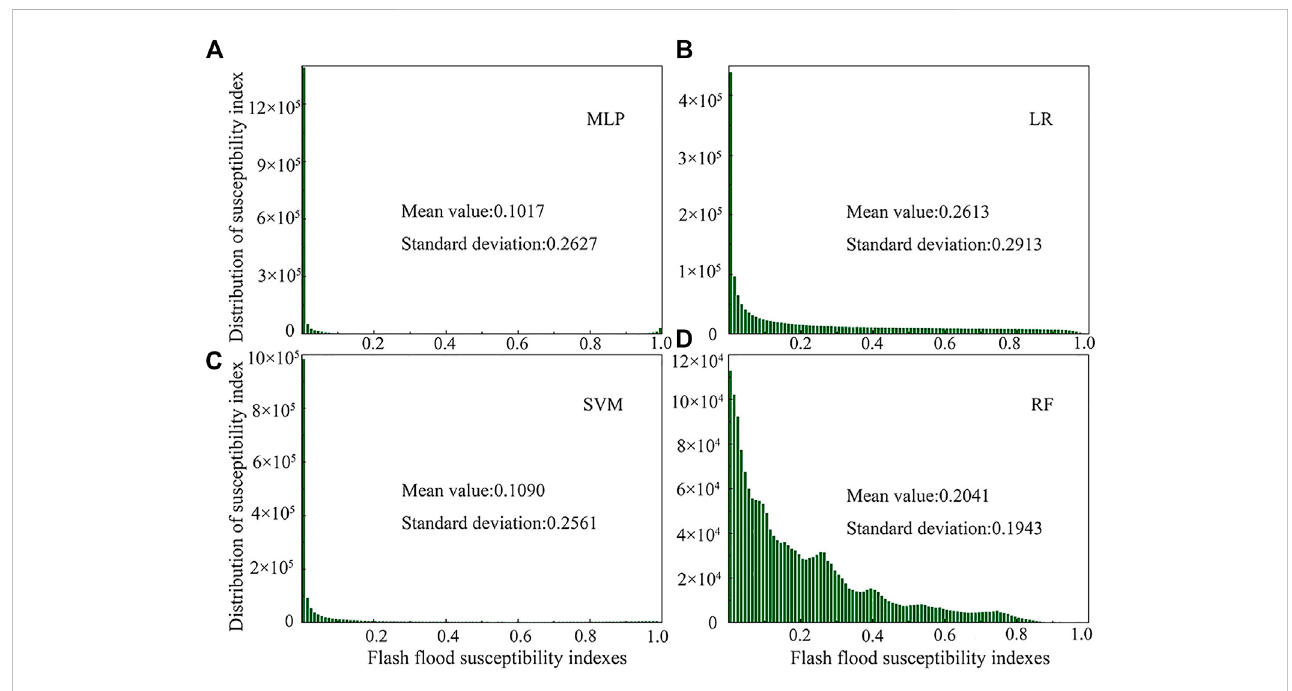
FIGURE 7 Distribution rule of fl ash fl ood susceptibility index: (A) MLP, (B) LR, (C) SVM, (D)